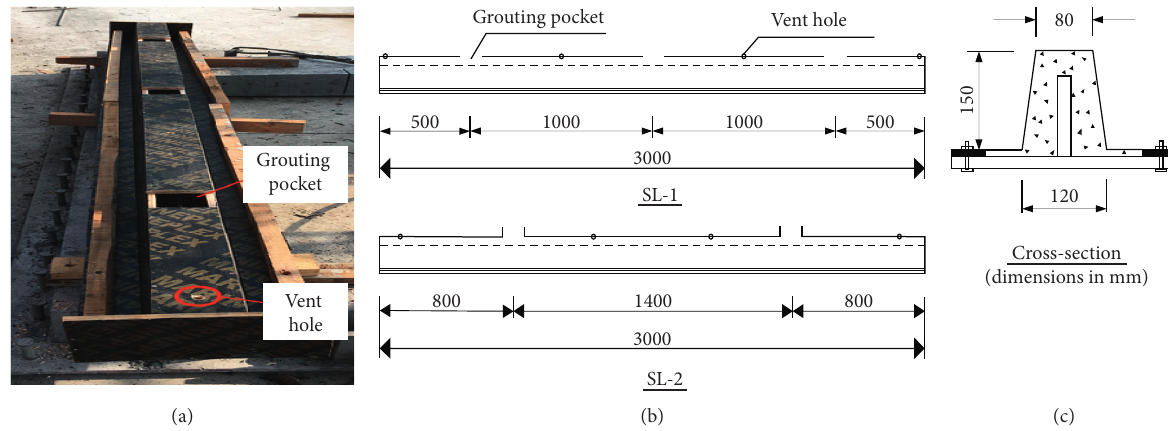
Figure 6: Test setup for self-levelling grouting from the top